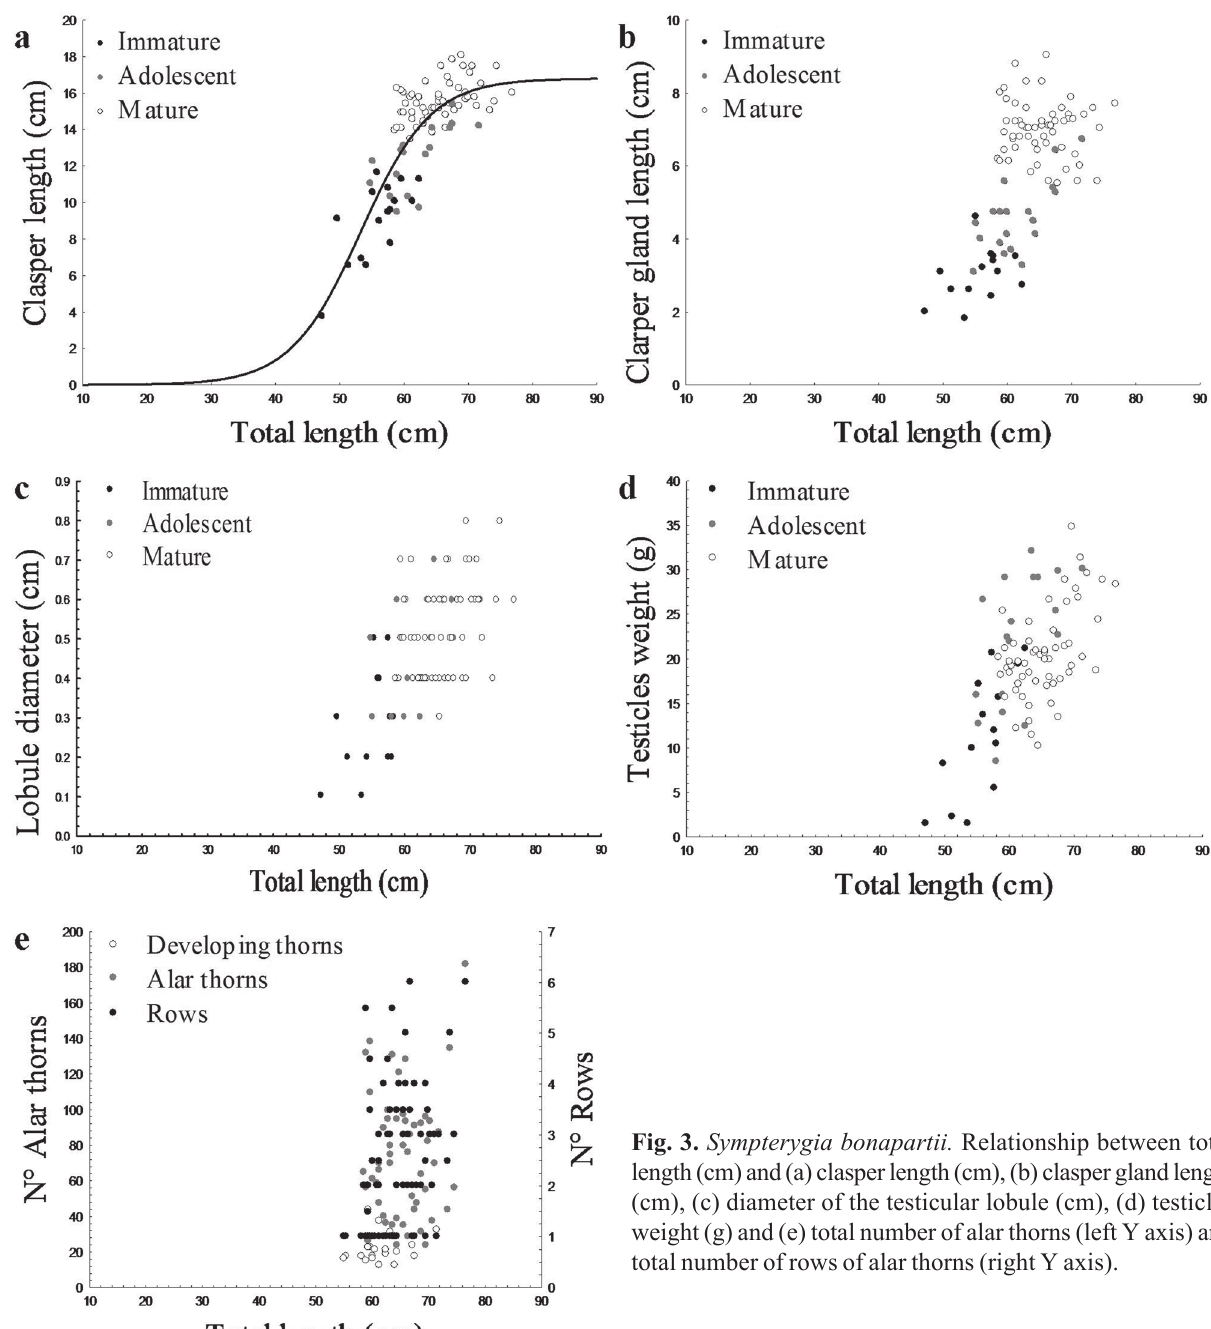
Fig. 3. Sympterygia bonapartii. Relationship between total length (cm) and (a) clasper length (cm), (b) clasper gland length (cm), (c) diameter of the testicular lobule (cm), (d) testicles weight (g) and (e) total number of alar thorns (left Y axis) and total number of rows of alar thorns (right Y